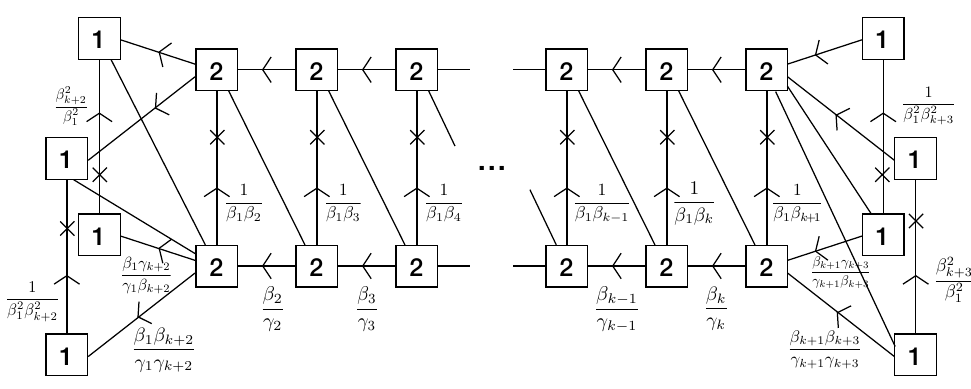
Figure 9 . Basic domain wall for D = f + ; + ; (cid:1) (cid:1) (cid:1) ; + g (cid:12) in the a(cid:14)ne D k +3 quiver theory. The boxes with 1 denote the 5d SU( N ) i =1 ; 2 ; 3 ; 4 gauge nodes and the boxes with 2 denote the 5d SU(2 N ) i =1 ; (cid:1)(cid:1)(cid:1) ;k gauge